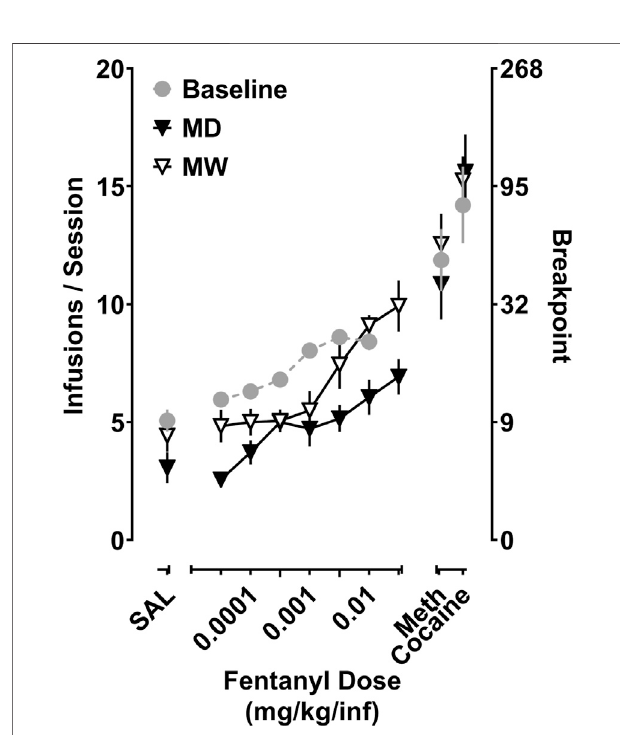
FIGURE 3 | Self-administration of fentanyl, cocaine, and methamphetamine in rats responding under a progressive ratio (PR) schedule of reinforcement. Data represent the mean ( ± SEM) for the total number of infusions earned for fentanyl (0.0032 – 0.032 mg/kg/inf), cocaine (0.32 mg/kg/inf), andmethamphetamine(0.032 mg/kg/inf) (leftordinate) ,as well as the corresponding fi nal ratio completed (right ordinate) . Each point represents six to eight